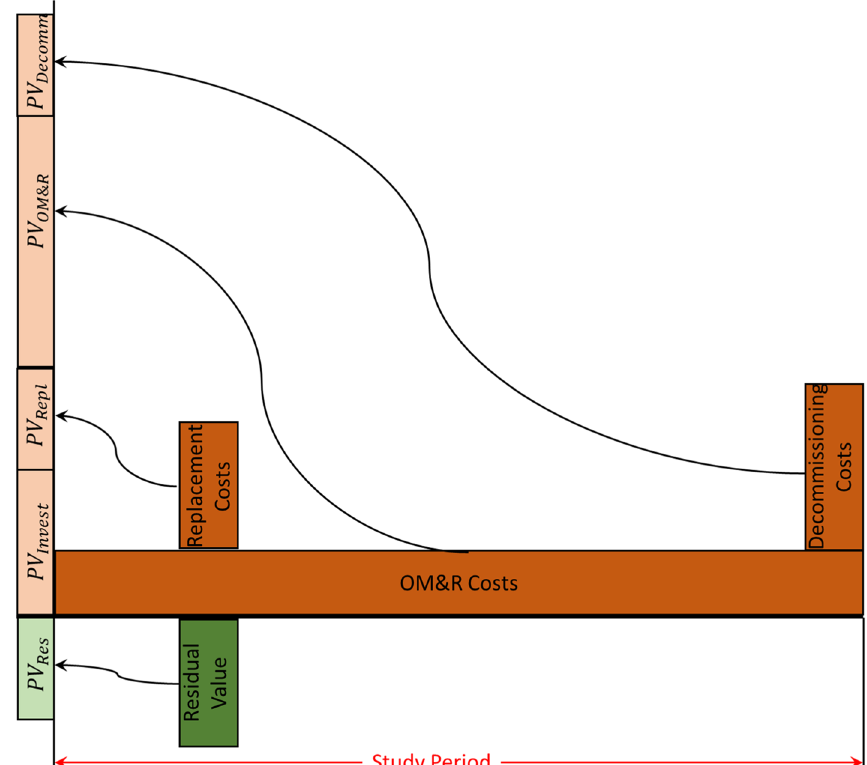
Fig. 7 Estimation of lifecycle cost by adding present values of different